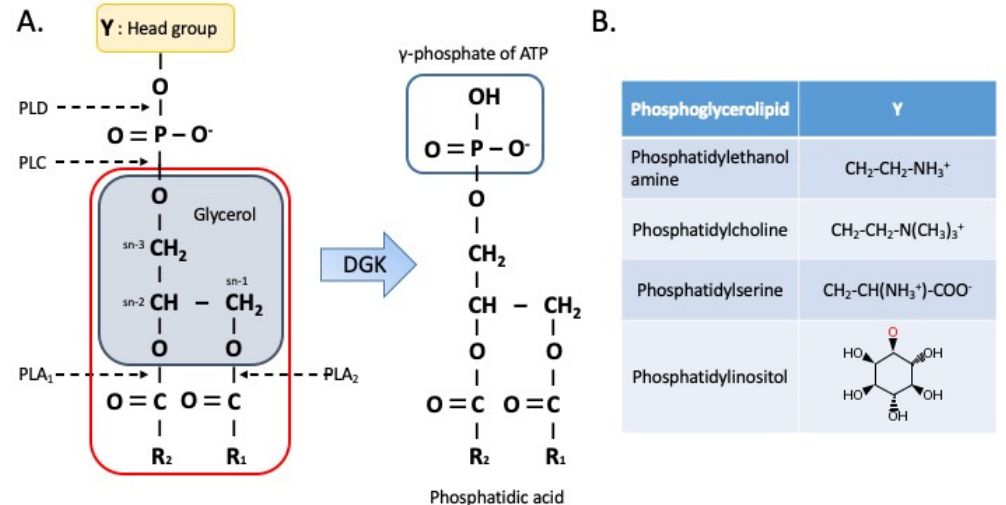
Figure 1. Structure of phosphoglycerolipid including diacylglycerol (DAG) and phosphatidic acid (PA). ( A ) The sites for phospholipase-mediated hydrolysis of phosphoglycerolipid are marked in letters. Structure of DAG is presented in a rounded red rectangle. ( B ) The head groups (Y) of selected phosphoglycerolipid classes are presented. Y is ethanolamine, choline, serine and inositol from top to bottom. O in red indicates hydroxyl group of phosphoglycerolipid where the inositol residue is bound. ATP, adenosine triphosphate; DGK, diacylglycerol kinase; PLA, phospholipase A; PLC, phospholipase C; PLD, phospholipase D. R 1 and R 2 are fatty acid residues.